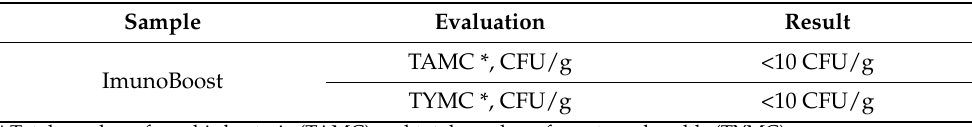
Table 3. Bioburden assessment of the novel nutraceutical. Sample